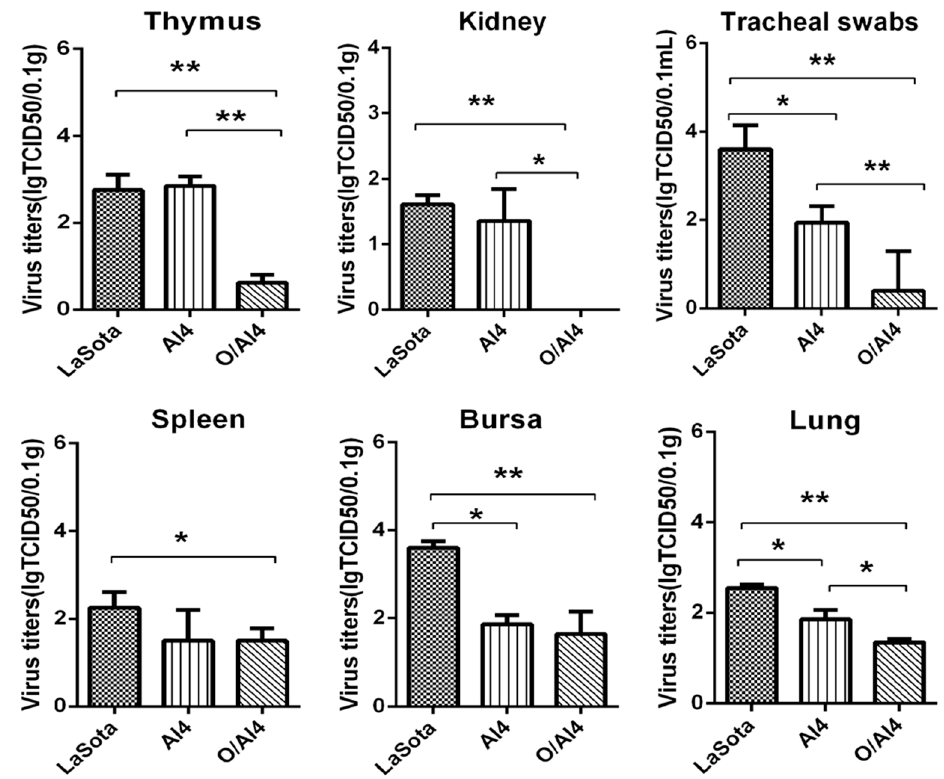
Figure 2. Viral load in visceral organs and tracheal swabs of chickens infected with JS-14-12-Ch at three days post challenge. Virus titers of the collected tissues were assessed in CEF cells and are presented as lgTCID 50 /0.1 g tissue and Virus titers of the collected tracheal swabs were assessed in CEF cells and are presented as lgTCID 50 /0.1 mL. * p < 0.05; ** p < 0.01.